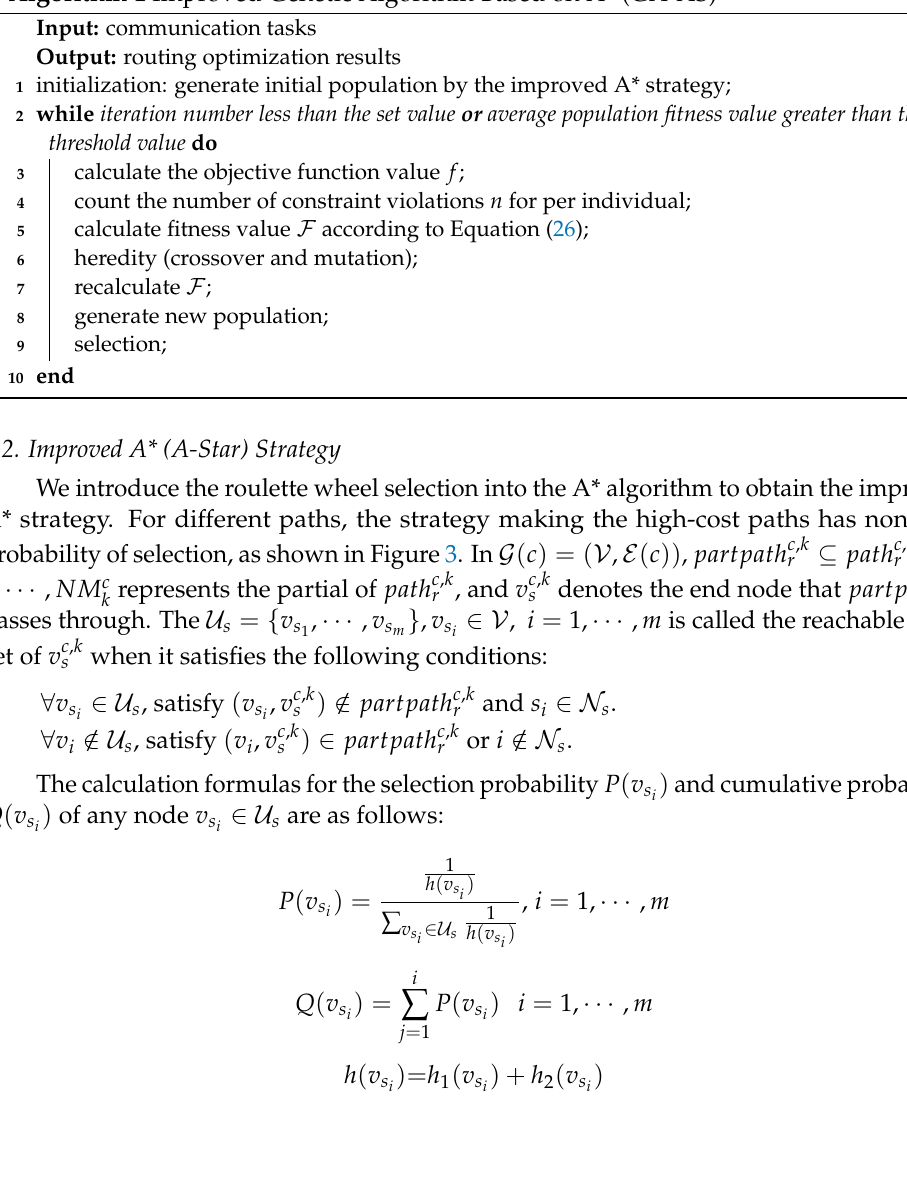
Algorithm 1 Improved Genetic Algorithm Based on A*